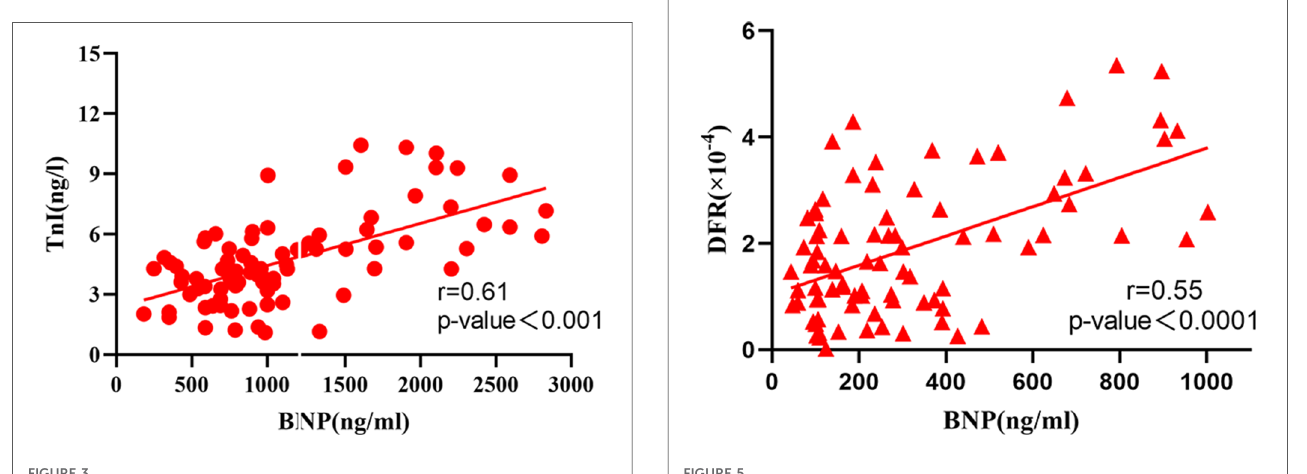
FIGURE 3 Correlation between serum BNP and TnI before operation.